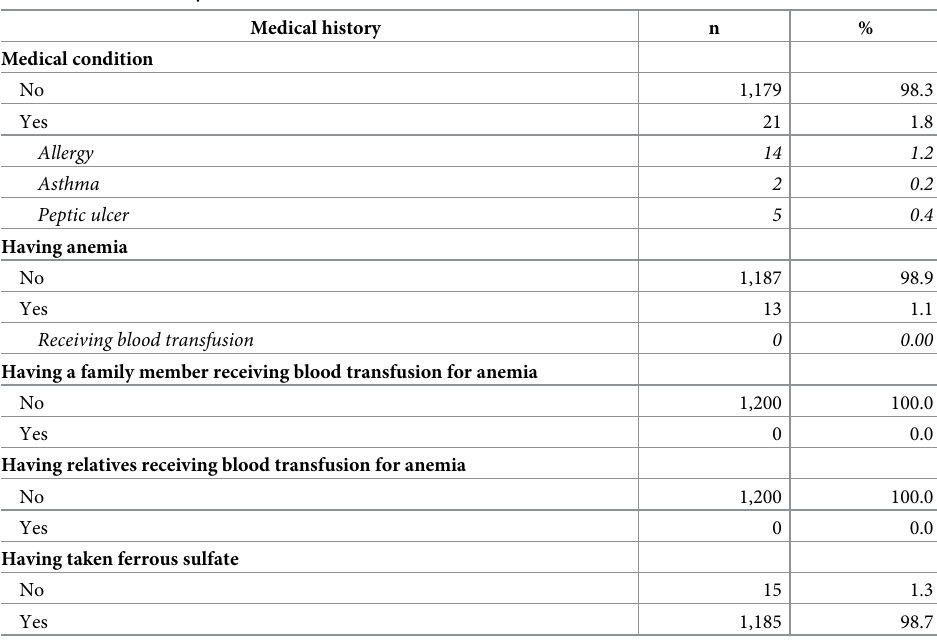
Table 2. Medical history.